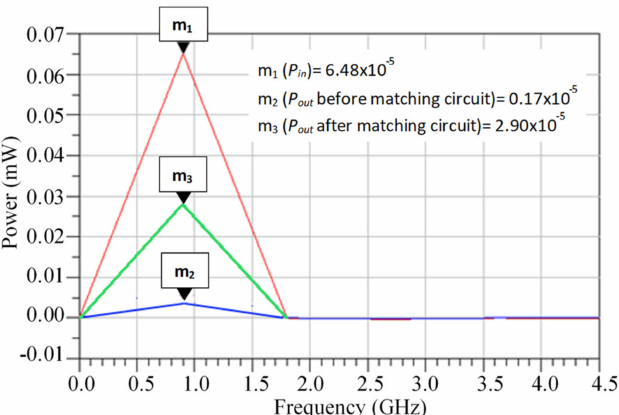
Figure 14. Power results of Cockcroft-Walton voltage multiplier